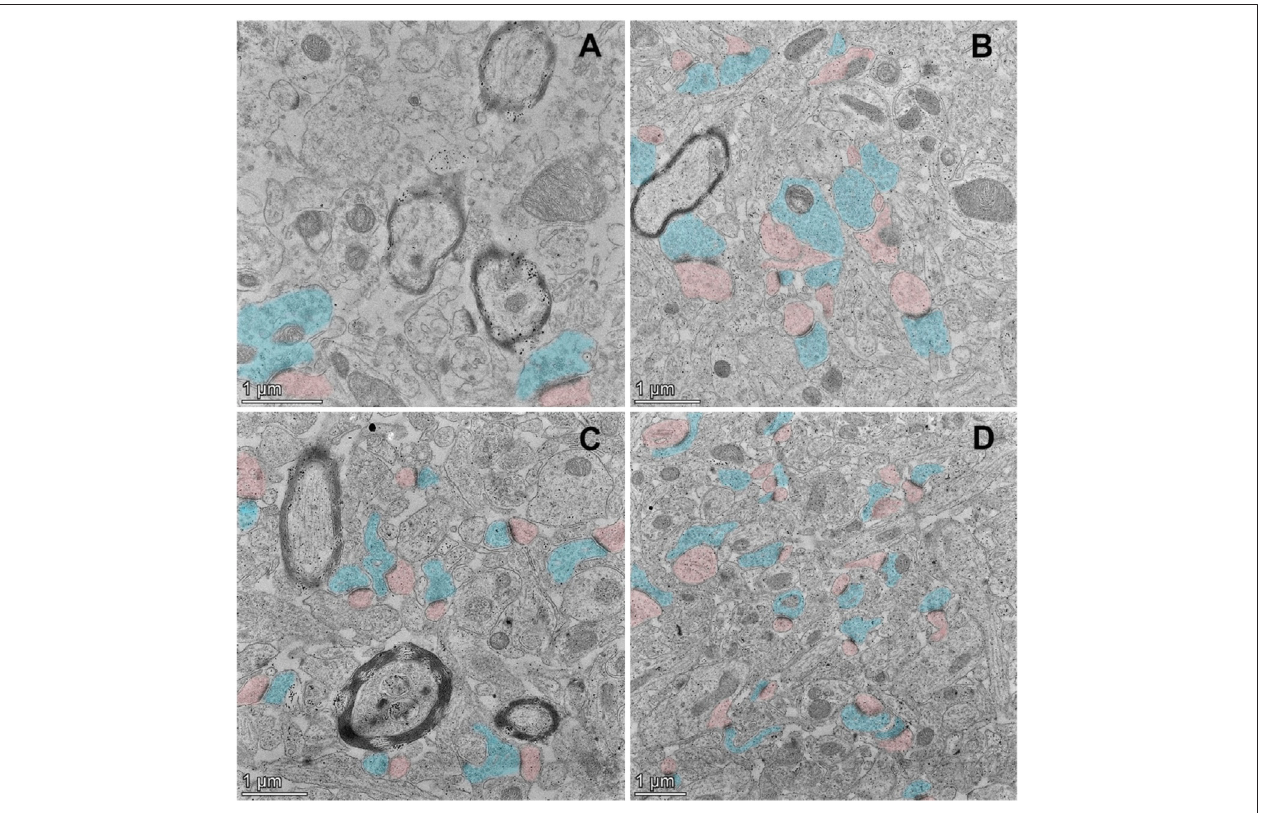
FIGURE 3 | TEM ultrastructural study on murine hippocampal CA1 region. The TEM micrographs of aged control mice (A) , young control mice (B) , and aged Pls- fed mice (C,D) . Pre-synaptic terminals are marked with blue color, and post-synaptic domains with pink color. The synaptic loss, synaptic degradation and deterioration were observed in aged controls (A) . On the contrary, abundant synaptic vesicles are present in the pre-synaptic terminals (marked in blue) of young controls (B) . There is a pronounced increase in the numbers and density of synapses in aged Pls-fed murine hippocampus with moderate numbers of synaptic vesicles (C,D) . Bars = 1 μ